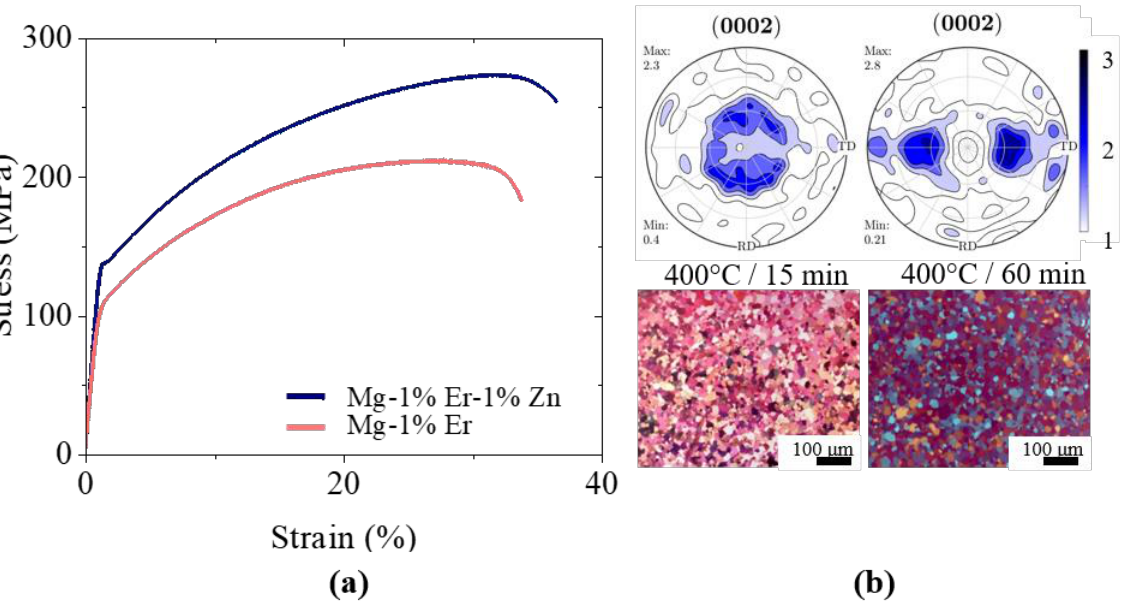
Figure 7. Uniaxial stress–strain response ( a ), optical micrographs and (0002) pole figures of Mg-1%Er annealed for 15 min and Mg-1%Er-1%Zn annealed for 60 min at 400 °C ( b ). The grain size prior to the tensile test was in the range of 14 to 16 µm for both samples.